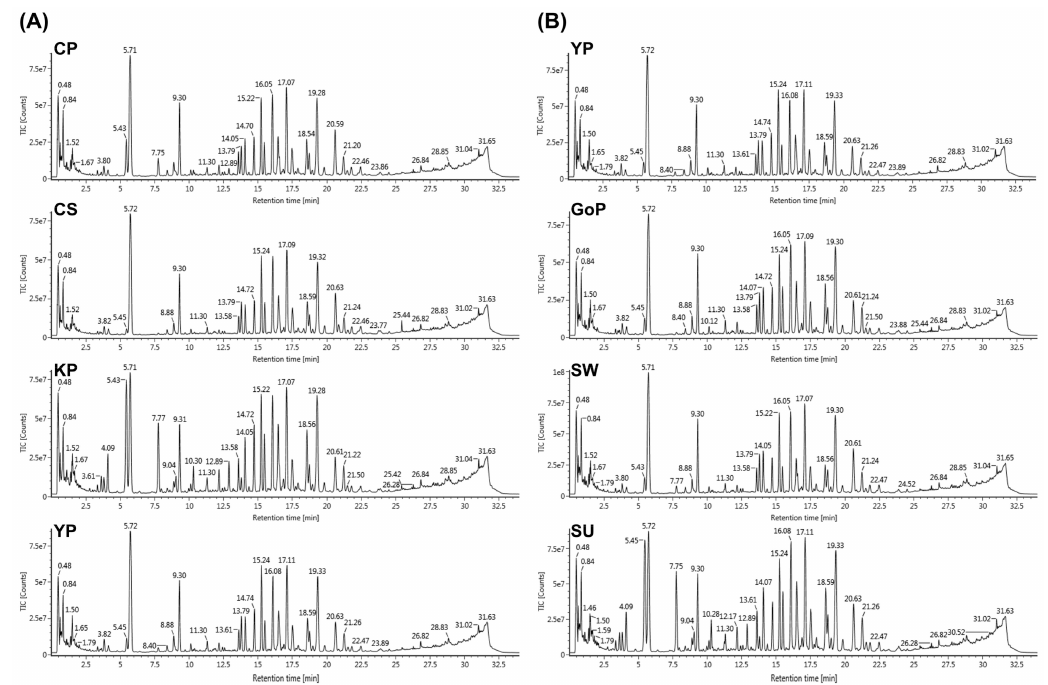
Figure 2. Representative ultra-performance liquid chromatography-quadrupole-time-of-flight mass spectrometry (UPLC–QTOF / MS) total ion chromatograms (TIC) of ginseng berry extracts. ( A ) Comparison ofrepresentativecultivarsineachvariant(CP,Chunpoong; CS, Chungsun; KP, Kumpoong; YP, Yunpoong). ( B ) Comparison of cultivars in the violet-stem variant (YP, Yunpoong; GoP, Gopoong; SW, Sunwon; SU, Sunun). See retention time in Table 1.